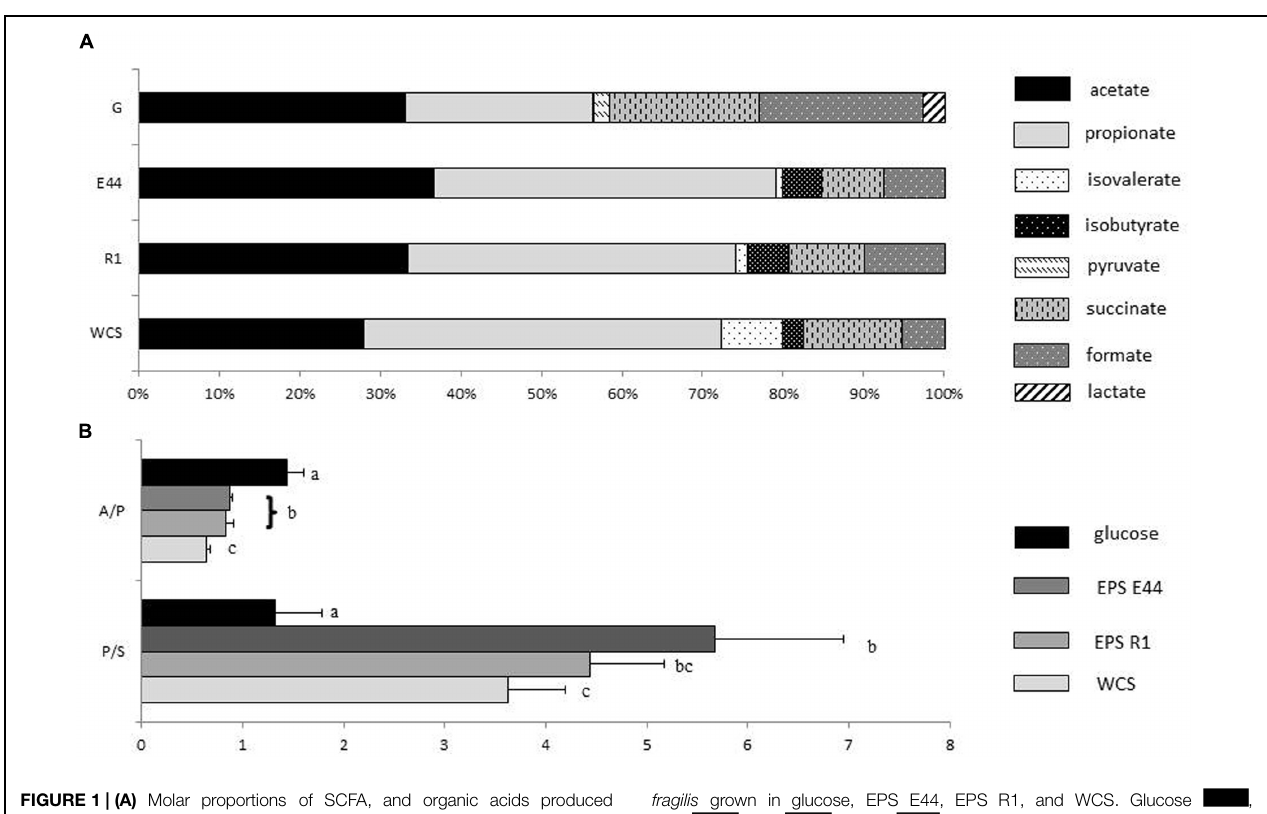
fragilis grown in glucose, EPS E44, EPS R1, and WCS. Glucose . Letters indicate significant differences among cultures with the different carbohydrates ( P < 0.05). Error bars represent standard deviations. Total metabolite production in glucose: 19.7 ± 1.06, EPS E44: 8.12 ± 1.85, EPS R1: 7.96 ± 0.95, and WCS:4.65 ± 0.39 mM.